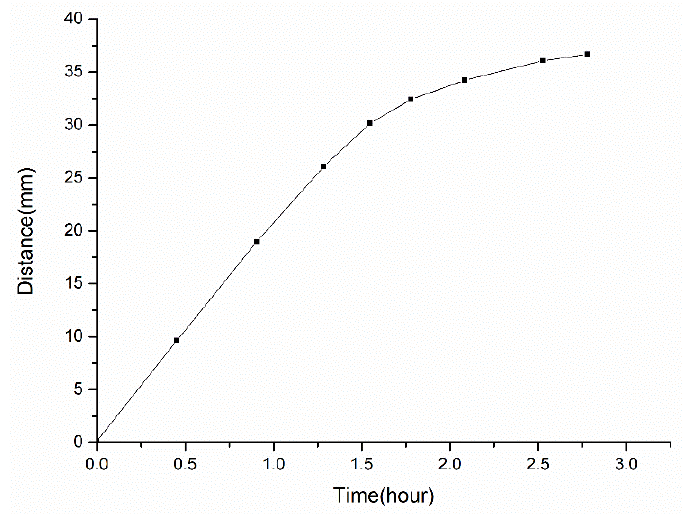
Figure 9. The penetration depth of the fracturing fluid versus time for core 57.